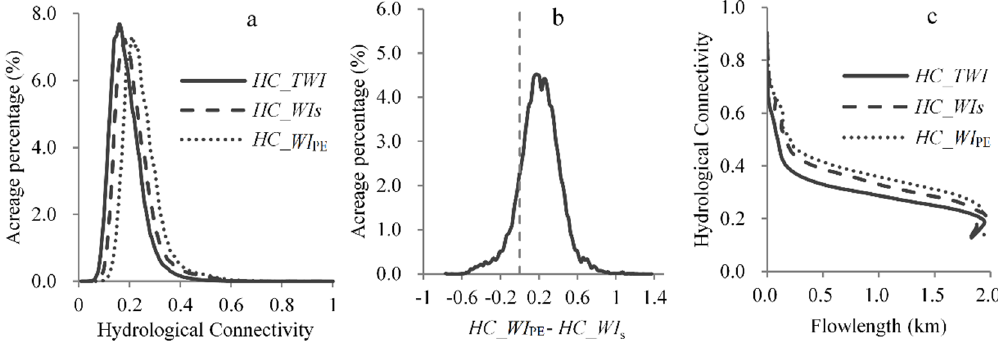
Figure 6. Acreage distribution of hydrological connectivity ( a ), the difference between HC_WI PE and HC_WI S ( b ), and hydrological connectivity variation corresponding to flow length ( c ).